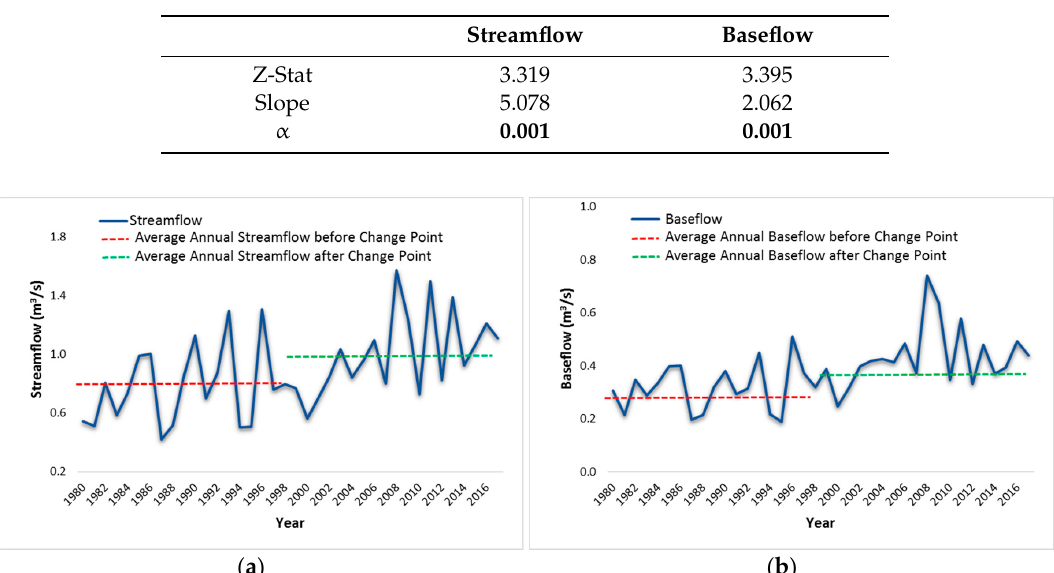
Table 4. Temporal trends in annual streamflow and baseflow in the LEC watershed.